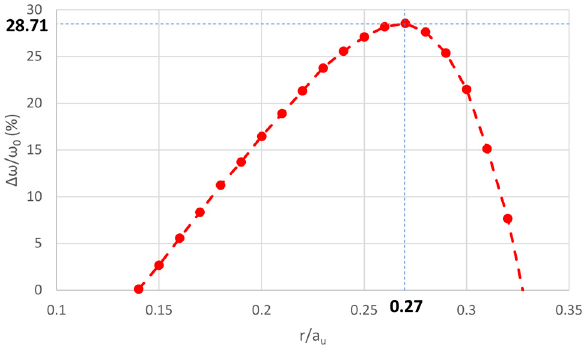
Figure 2. Gap-width to center-frequency ratio ∆ ω / ω 0 (between band 2 and band 3), as a function of the normalized rod radius r / a u for inverse RCD structures at a refractive index contrast of n bg :n c = 3.6:1. It shows a maximal gap width of ∆ ω / ω 0 = 28.71% for r/a u = 0.27.